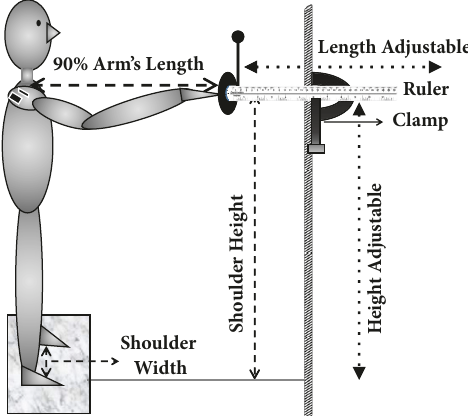
Figure 1: Experimental set-up showing custom-made apparatus, including a ruler and eye-fixator marker held by clamp complex, attached to the stationary pole and adjustable in height and